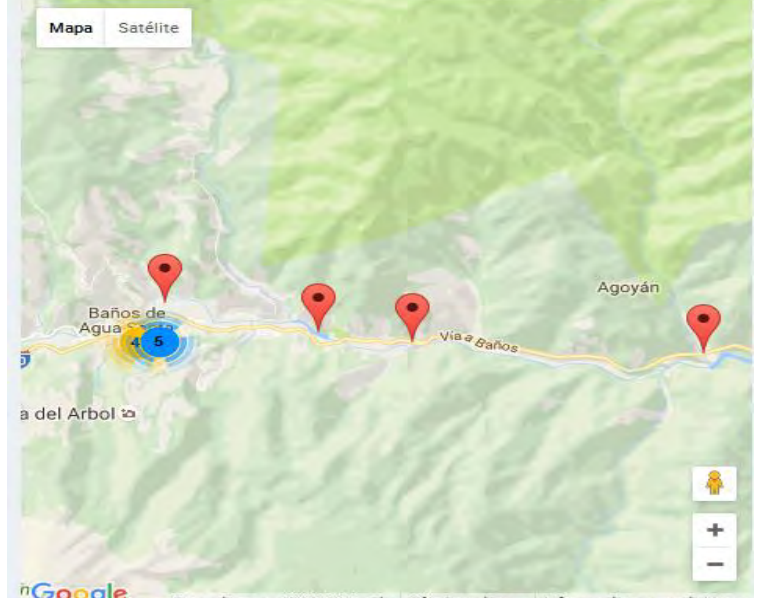
Figure 1 A look of the map with dots to locate the establishments and Tour Operators of Baños de Agua Santa in the province of